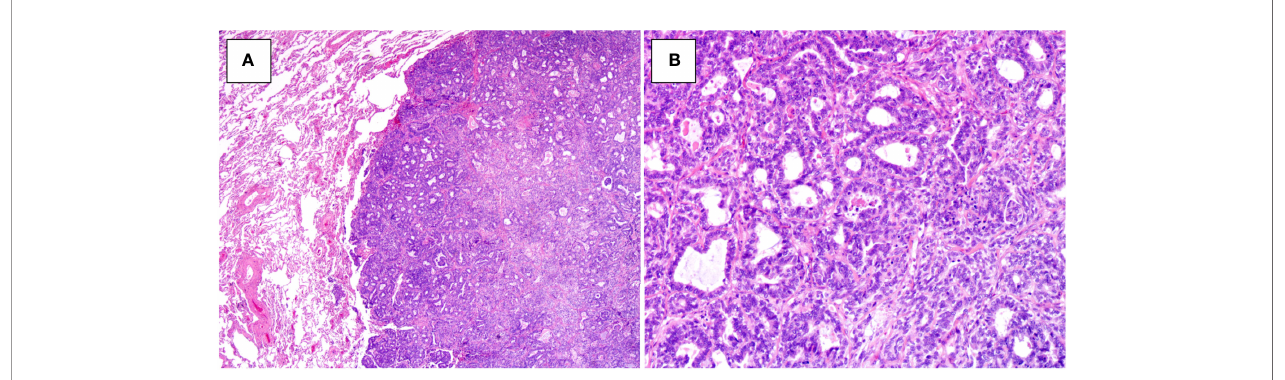
FIGURE 3 | Histopathologic fi ndings of metastatic MLA to the lung in case 3. (A) Well-demarcated nodular lesion (HE×20). (B) The lesion consists of dense tubules and glands, mimicking a primary invasive lung